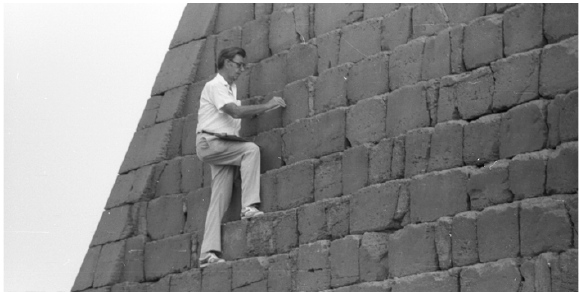
Figure 1. Friedrich W. Hinkel measuring blocks of pyramid N8 at Begrawiya/Meroe (Negative No. D-DAI-Z-Arch-FWH-F- KB-sw-542-70, © Deutsches Archäologisches Institut).